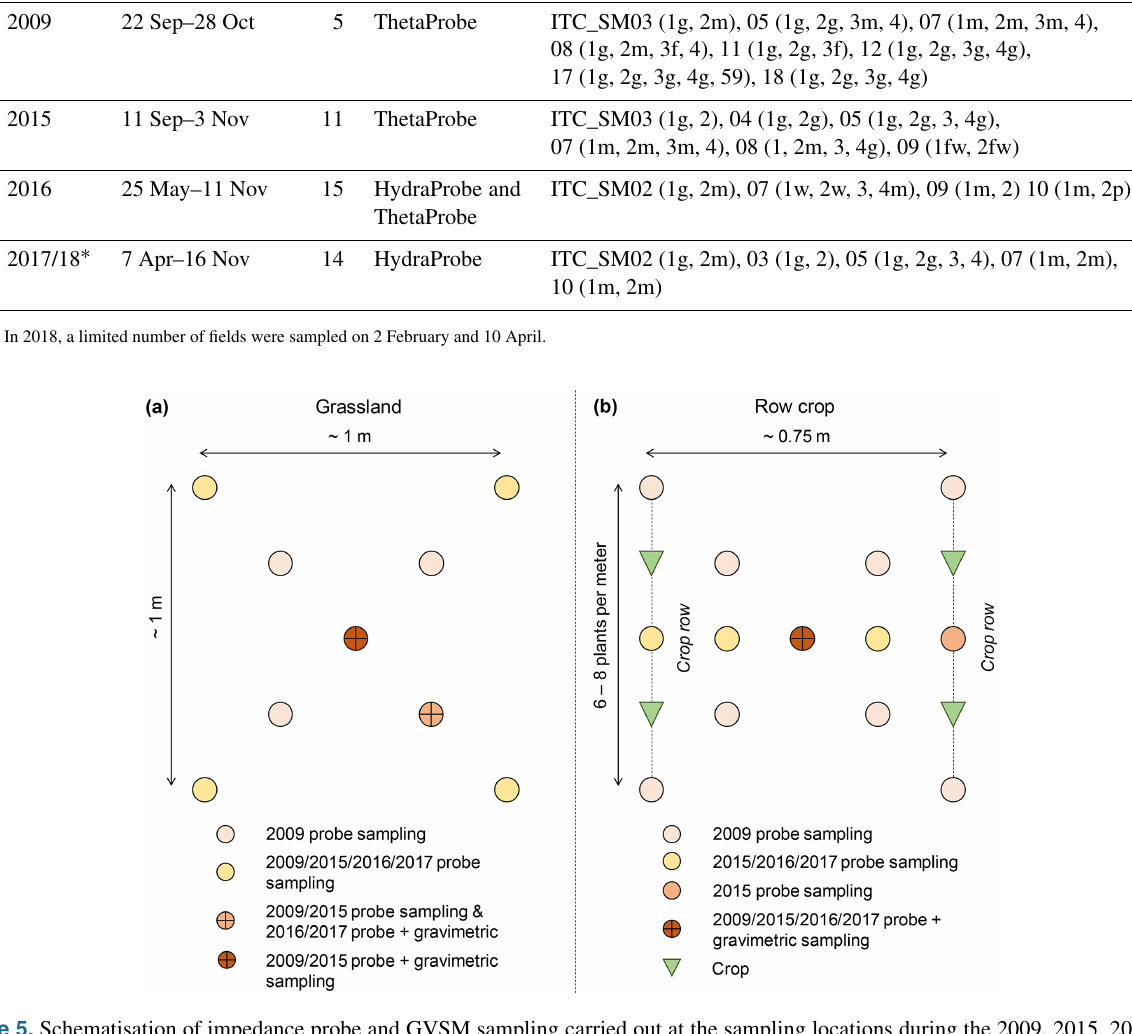
Figure 5. Schematisation of impedance probe and GVSM sampling carried out at the sampling locations during the 2009, 2015, 2016, and 2017 field